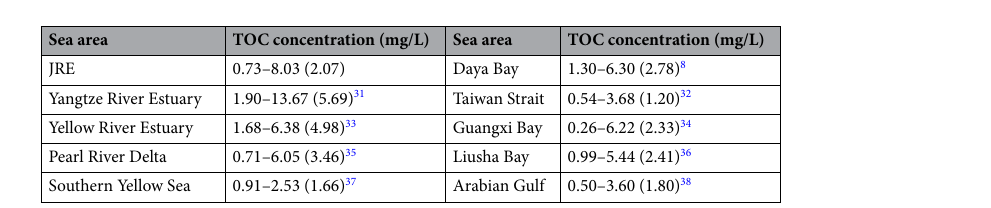
Table 1. TOC concentration by oceanic